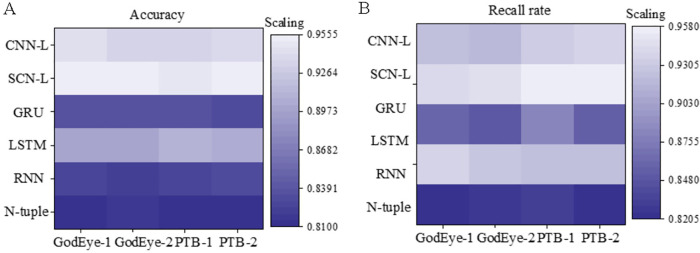
Evaluation of accuracy and recall rate of machine translation model of neural network based on residual and LSTM.Note: GodEye-1 is the training set on GodEye data, GodEye-2 is the test set on GodEye data, PTB-1 is the training set on PTB data, PTB-2 is the test set on PTB data, CNN-L is CNN-LSTM, SCN-L is SCN-LSTM model.